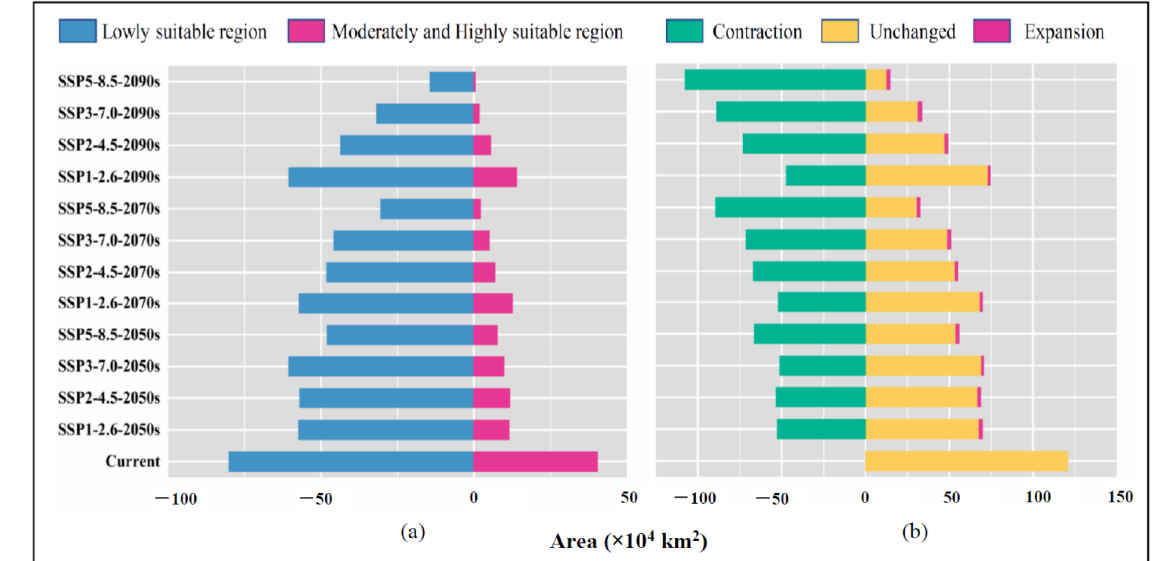
Figure 5. Areas ( a ) and changes ( b ) of habitats of different suitability for Coptis chinensis in China in different periods.